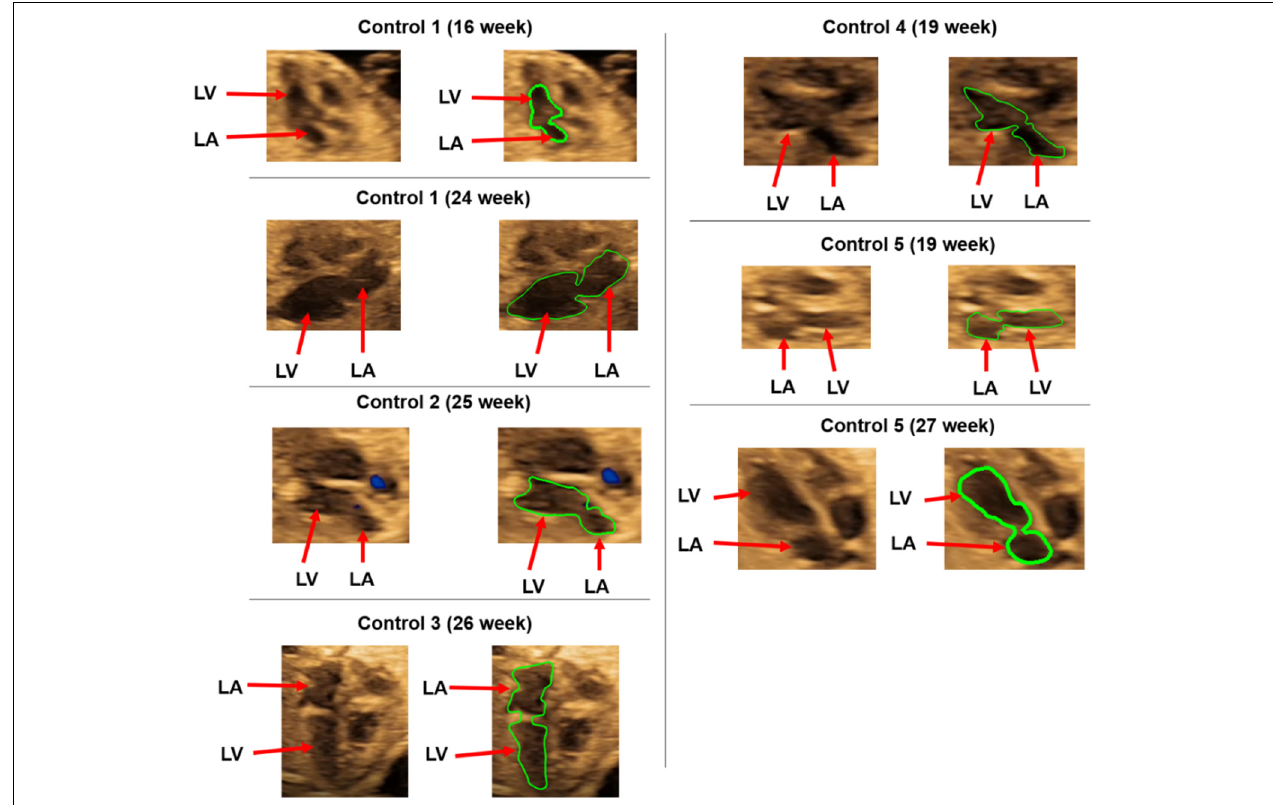
FIGURE 2 | Control hearts used for the CFD analysis. The boundaries of the left ventricle (LV) and left atrium (LA) are shown in green.